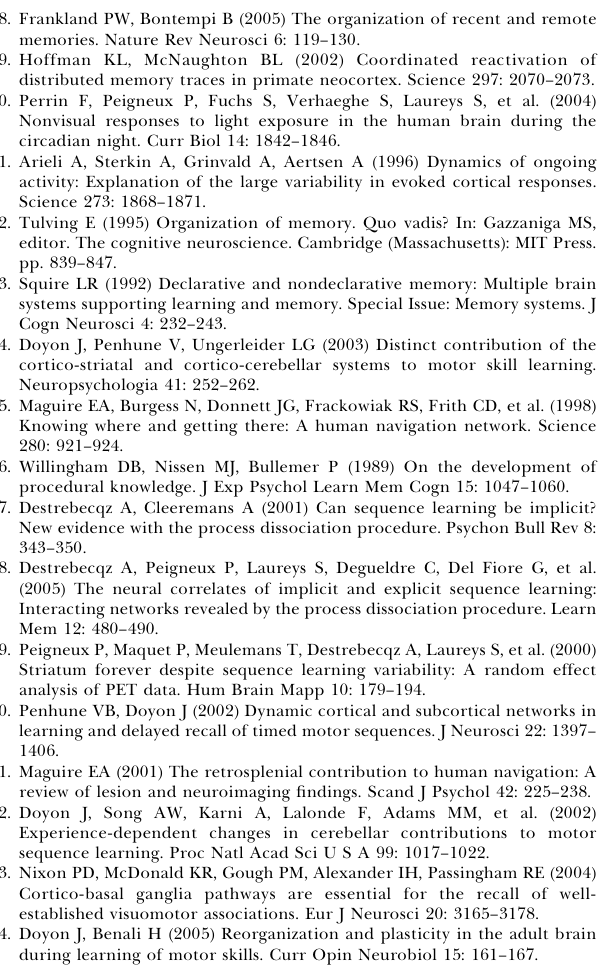
Figure S3. Session-Specific Parameter Estimates